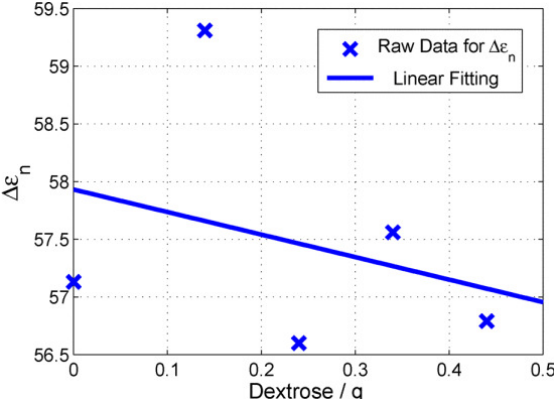
Figure 2. Glucose-dependent change in ∆ (cid:101) parameter collected from the blood-mimicking phantoms with glucose levels ranging from 0 mg/dL to 216 mg/dL, reported in